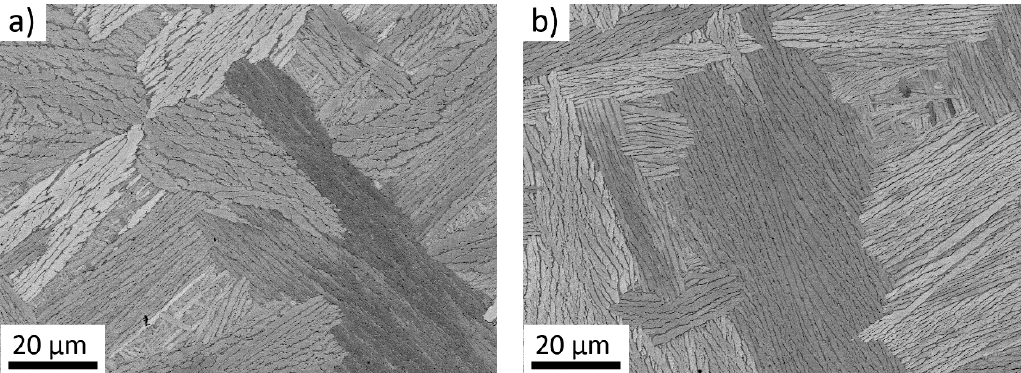
Figure 1. Coarse lamellar α + β microstructure of the alloys in the cast + homogenized condition ( a ) Zr-4Sn-4Nb ( b ) Zr-8Sn-4Nb.